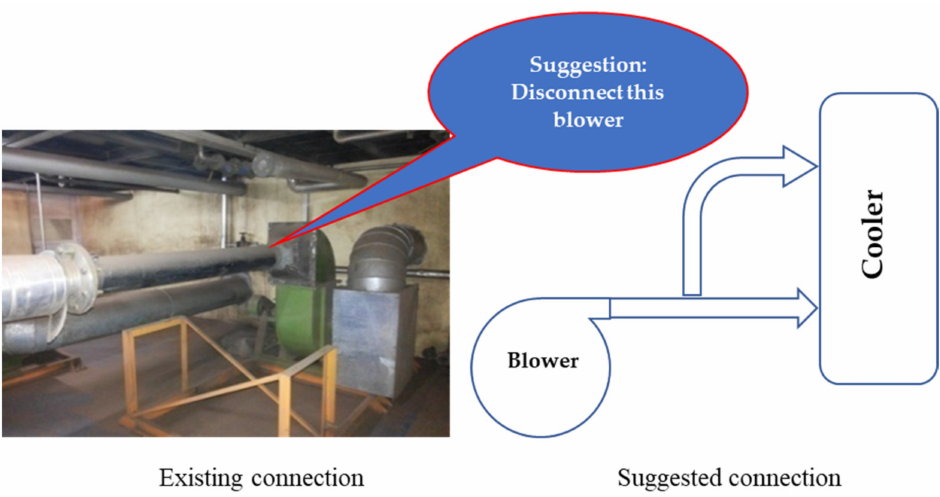
Figure 9. The suggestion to remove one blower for energy